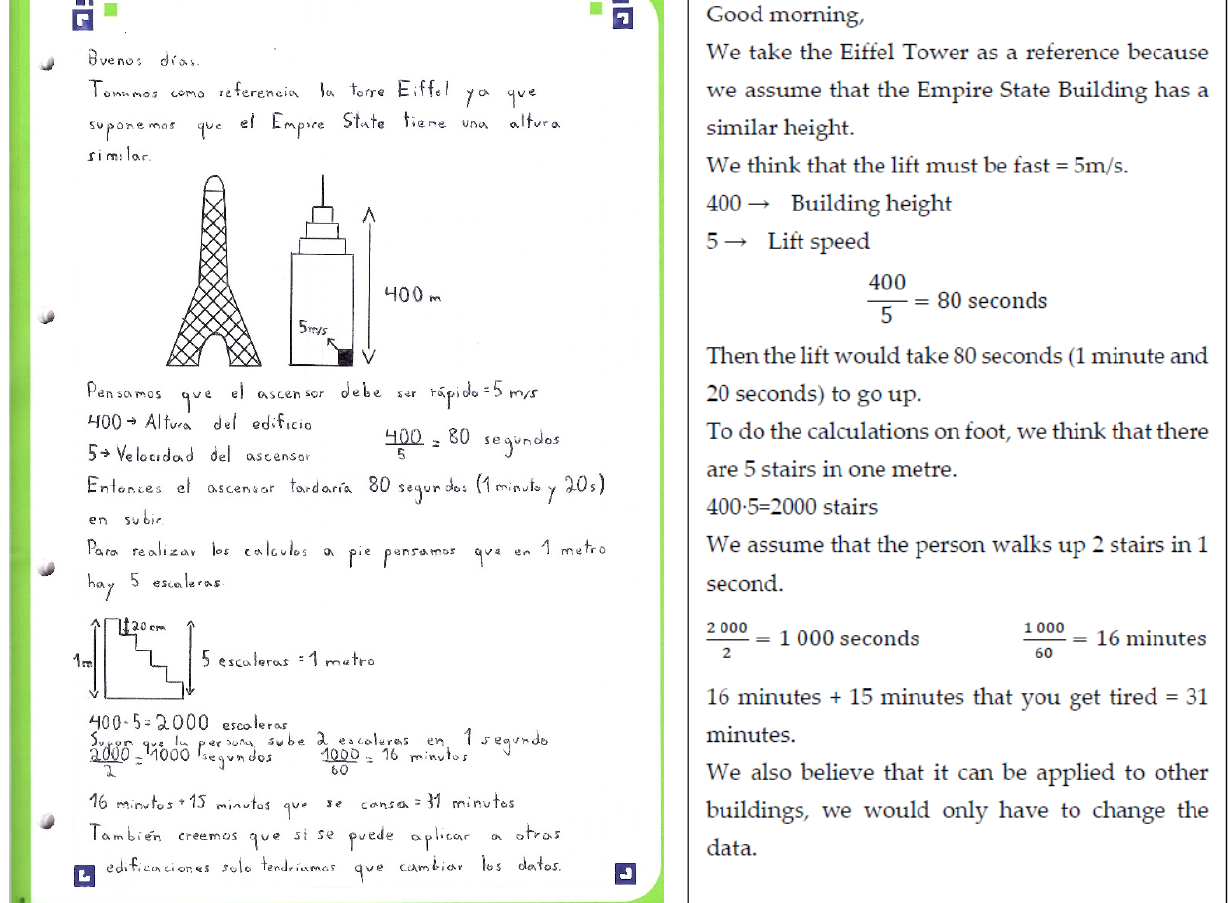
Figure 3. Original letter produced by the students and English translation.